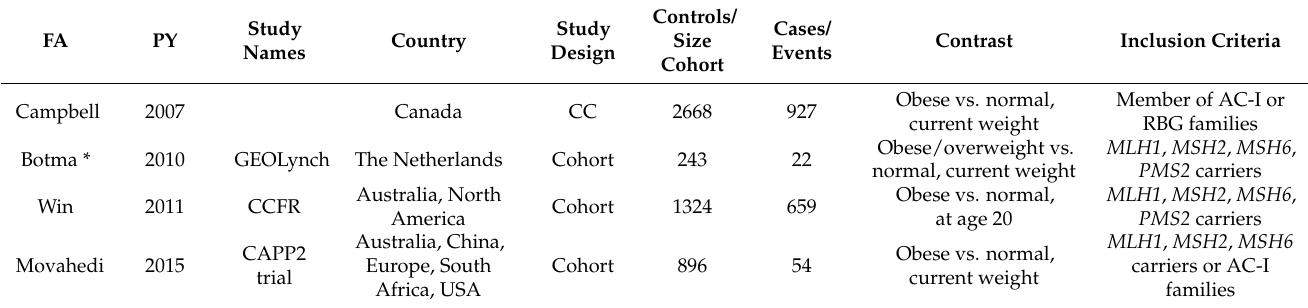
Table 1. Main characteristics of the studies included in the